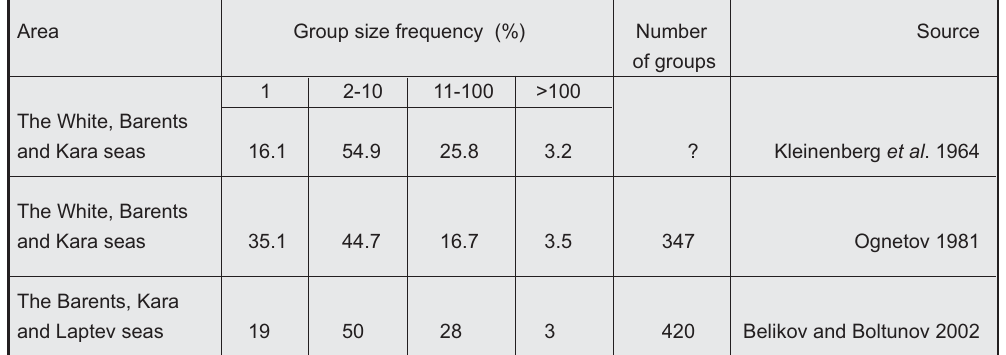
Table 1. Frequency of different group sizes of belugas in the Barents, White, Kara and Laptev